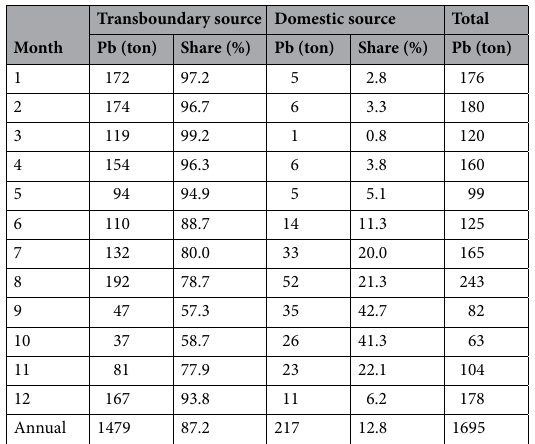
Table 1. Pb fluxes calculated through wet depositions over Japanese